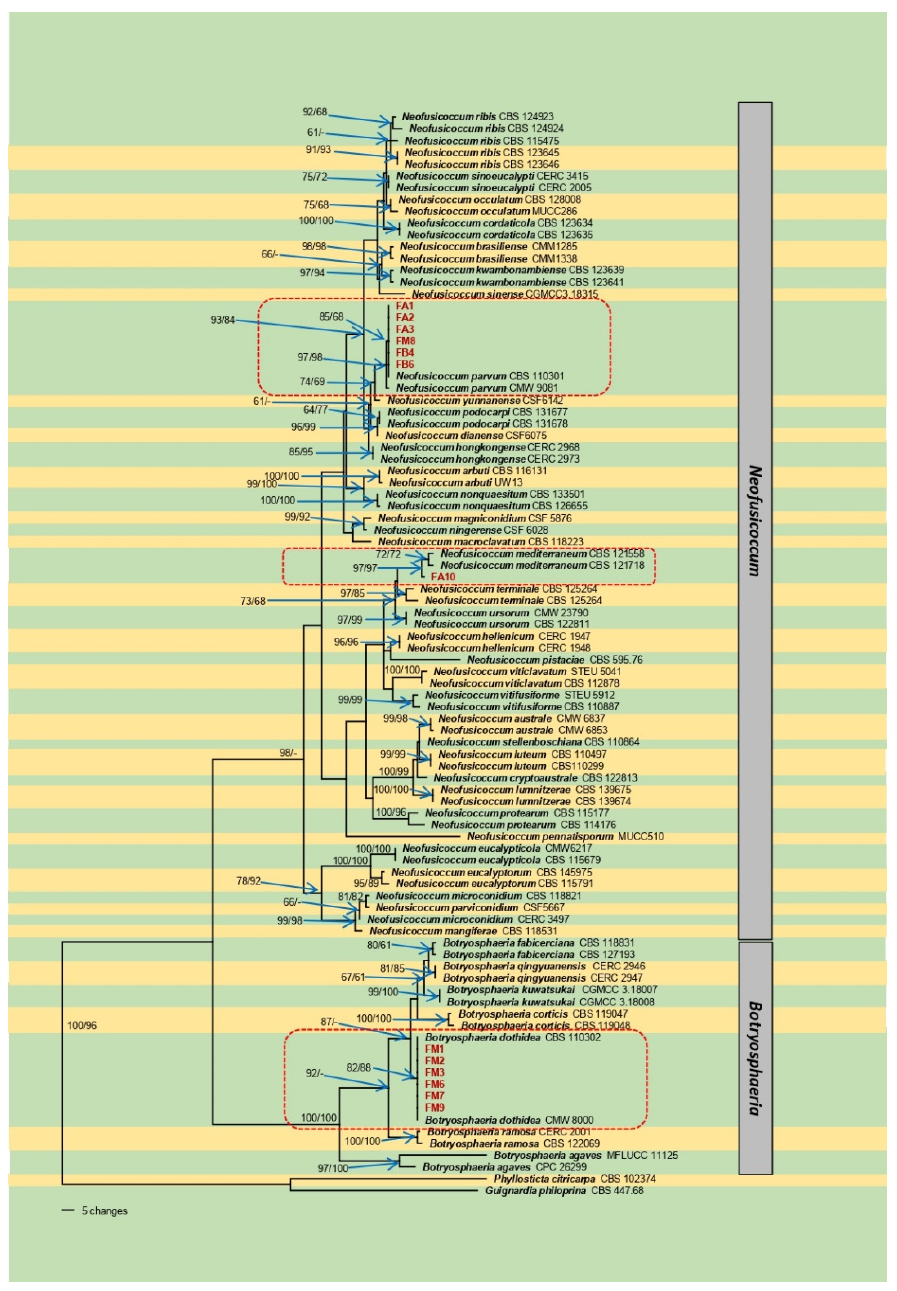
Figure 3. One of 100 equally parsimonious trees generated from maximum-parsimony analysis of the three-gene (ITS + tef1 - α + tub2 ) combined dataset from Botryosphaeriaceae species. Numbers in front and after the slash represent parsimony and likelihood bootstrap values from 1000 replicates, respec- tively. Isolates in red were generated in this study. Bar indicates the number of nucleotide